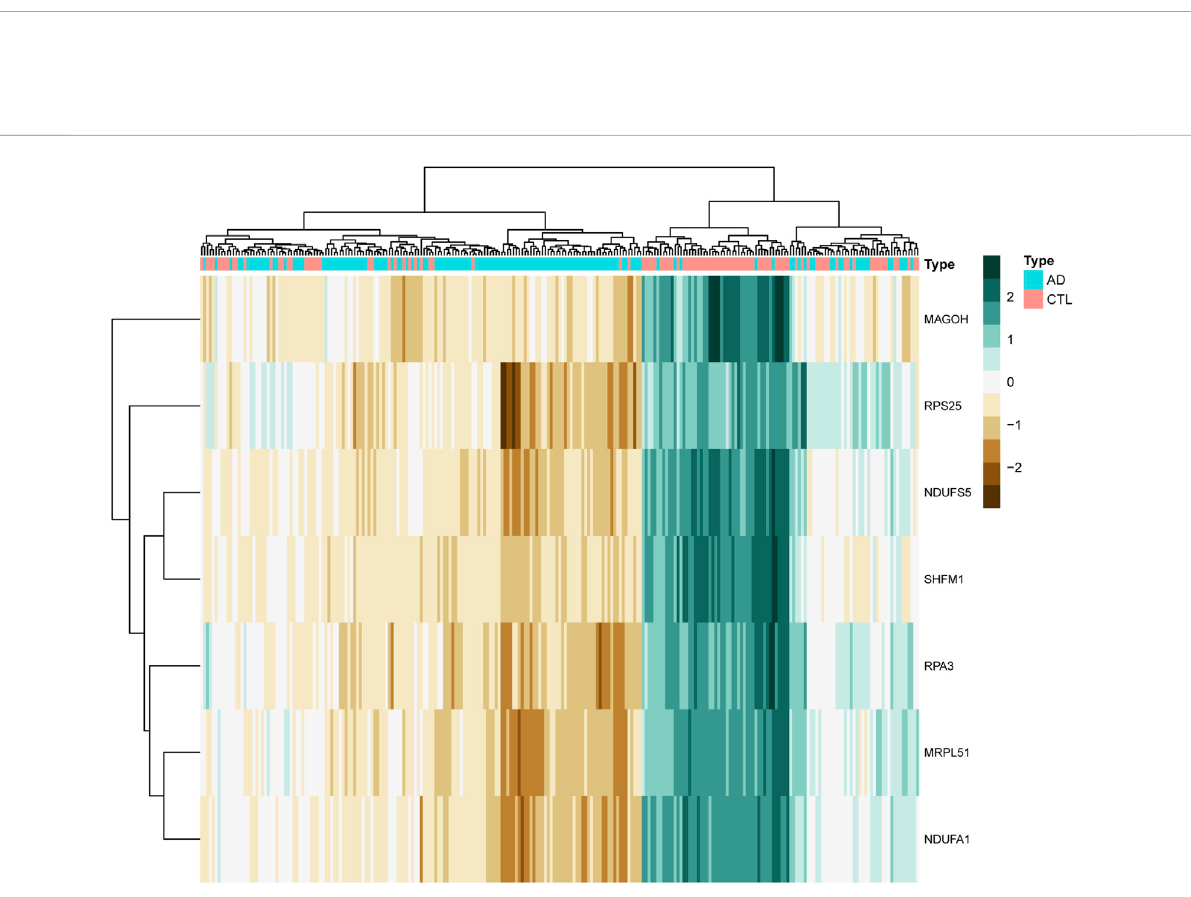
FIGURE 7 (A) Plot of decision tree versus error. The x -axis represents the number of decision trees; the y -axis represents the error. (B) Screening of hub genesby Ginicoef fi cient method. The X -axisrepresents theimportanceindex, the y -axis represents theDEGs, and all DEGs areranked according to the “ mean reduction Gini coef fi cient. ” The higher the value, the closer the relationship between the gene and the